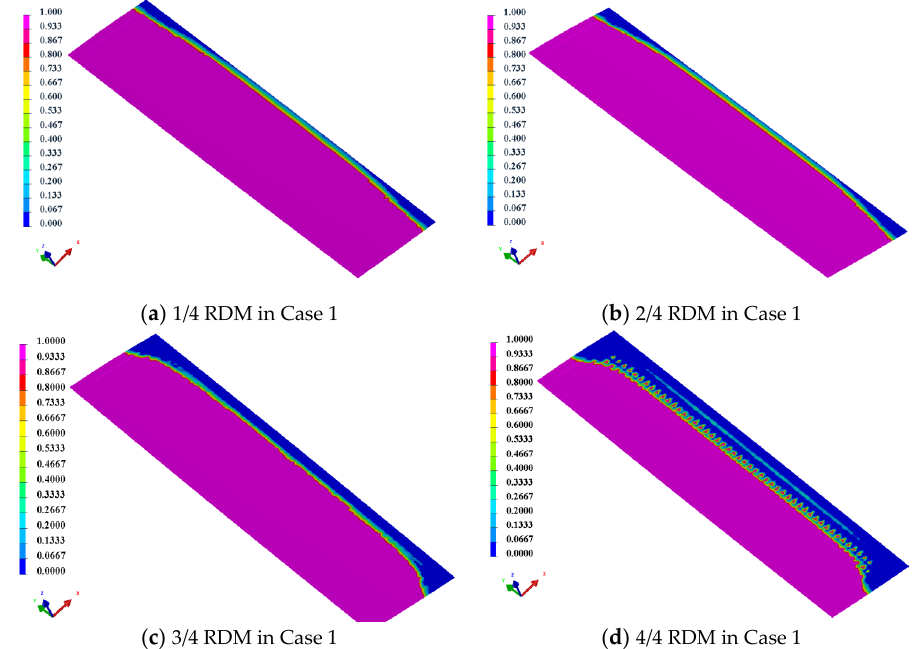
Figure 9. Resin flow front in Case 1.